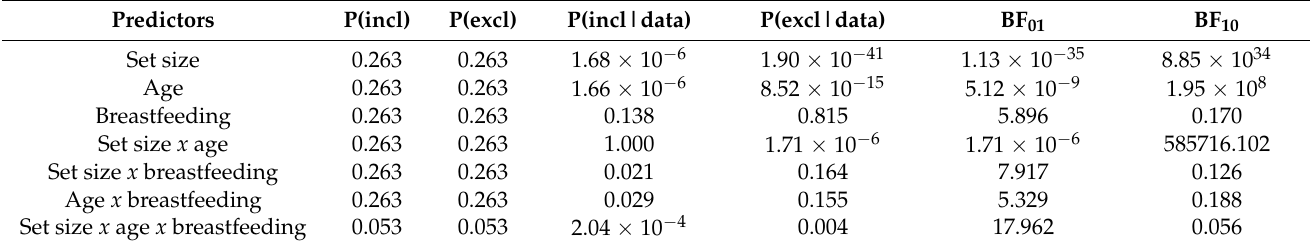
Table 4. Analysis of the effects in the Bayesian ANOVA conducted on the data derived by the CCT. Predictors